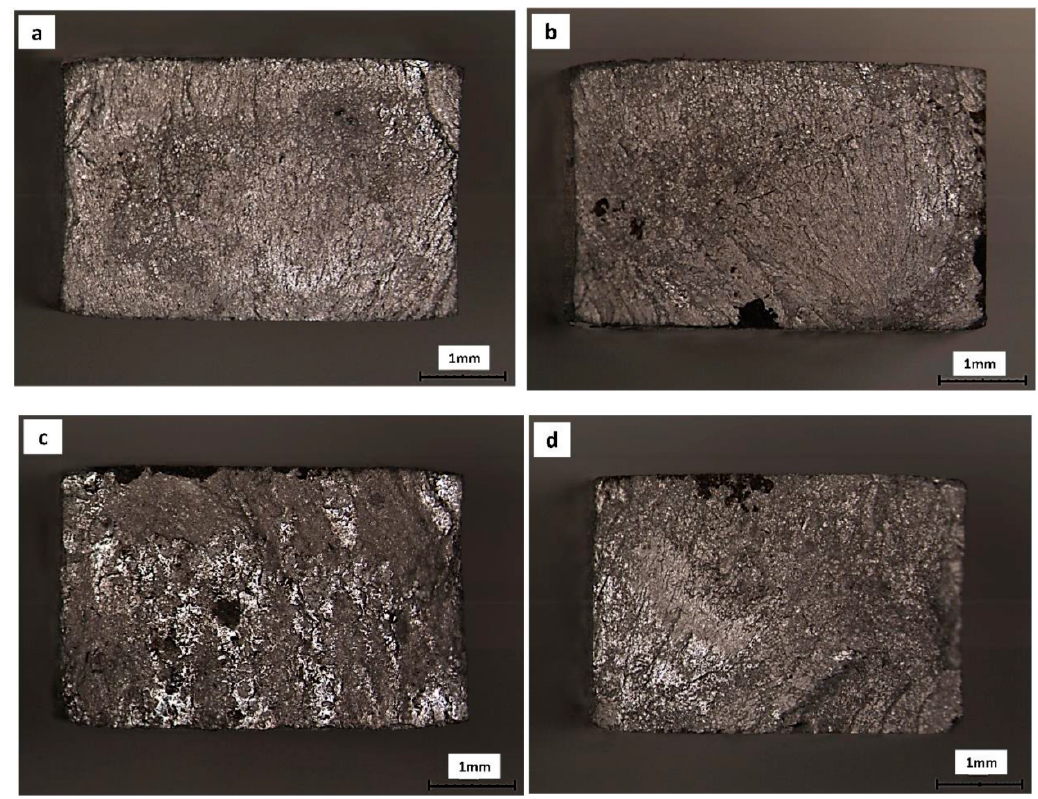
Figure 10. The typical fracture surfaces obtained after the LCCF in the PBS solution: ( a ) Mg-5Zn, ( b ) Mg-5Zn-1Nd, ( c ) Mg-5Zn-2Nd and ( d ) Mg-5Zn-3Nd.